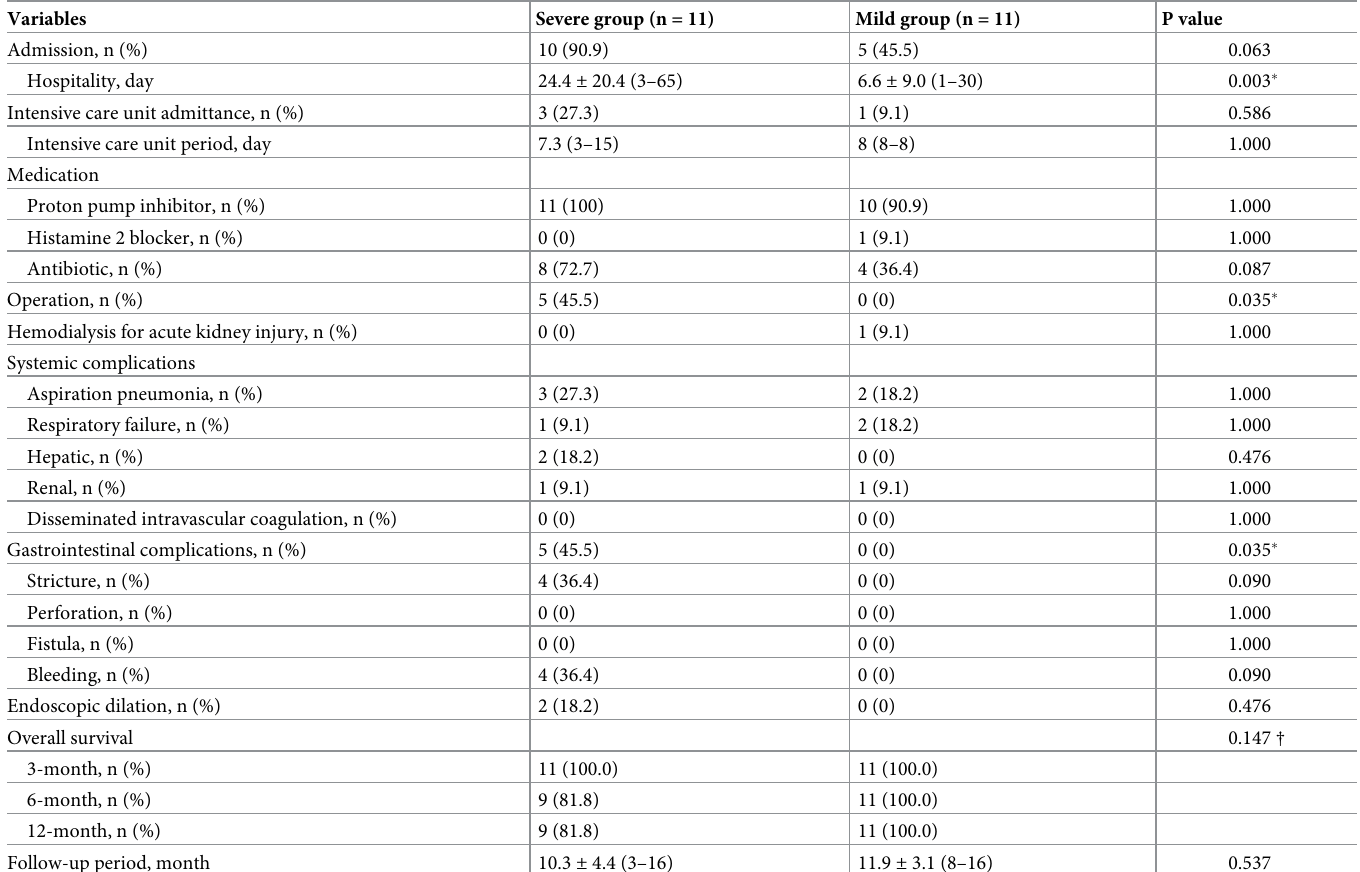
Table 4. Clinical outcomes of patients with caustic gastrointestinal tract injury (n = 22). Variables